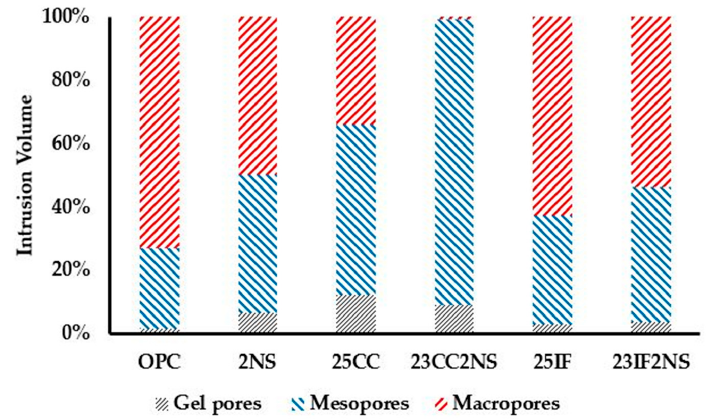
Figure 8. Intrusion volume distribution between regions of gel pores, mesopores, and macropores.